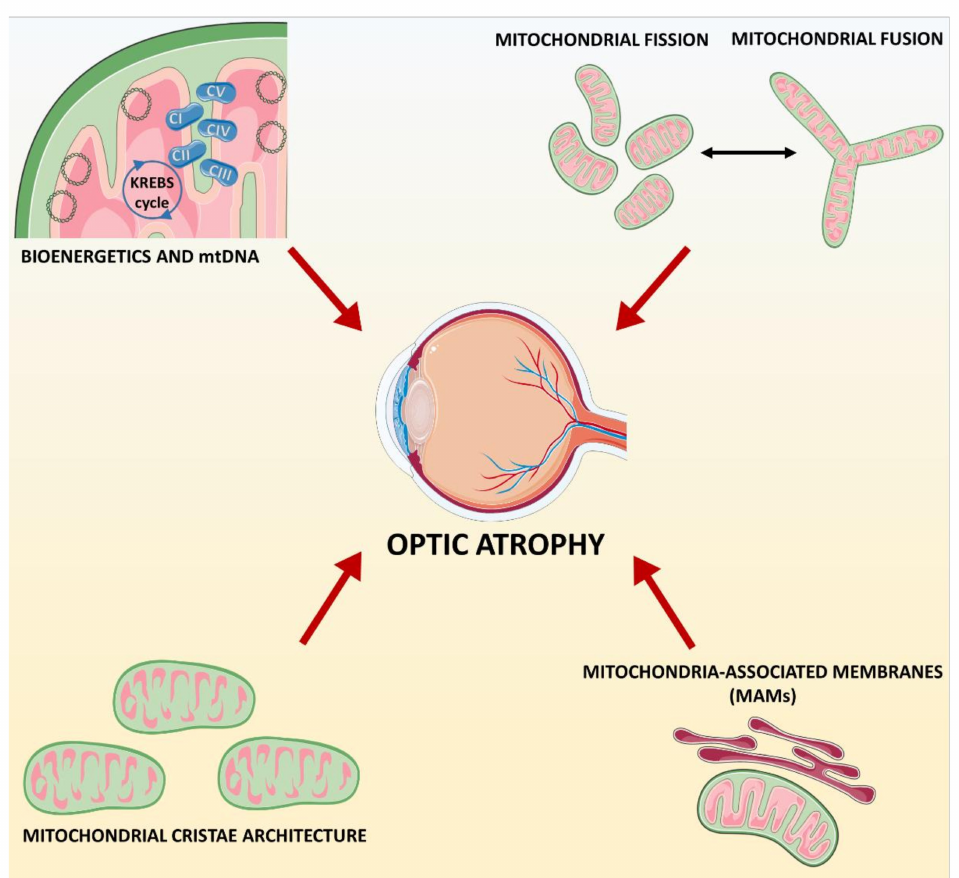
Figure 6. Molecular pathways behind inherited optic atrophy. Bioenergetics, mtDNA maintenance, mitochondrial dynamics, mitochondrial cristae morphology and MAMs are the principal intercon- nected pathways implicated in the degeneration of optic